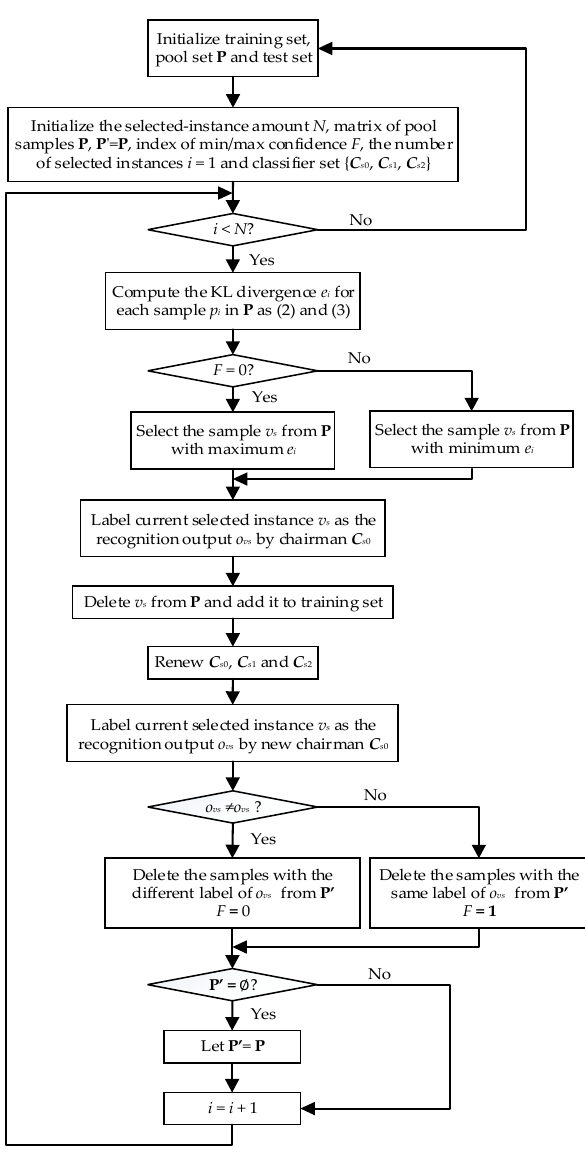
Figure 1. Flow chart of active learning on adaptive confidence rule (AL-ACR) algorithm.